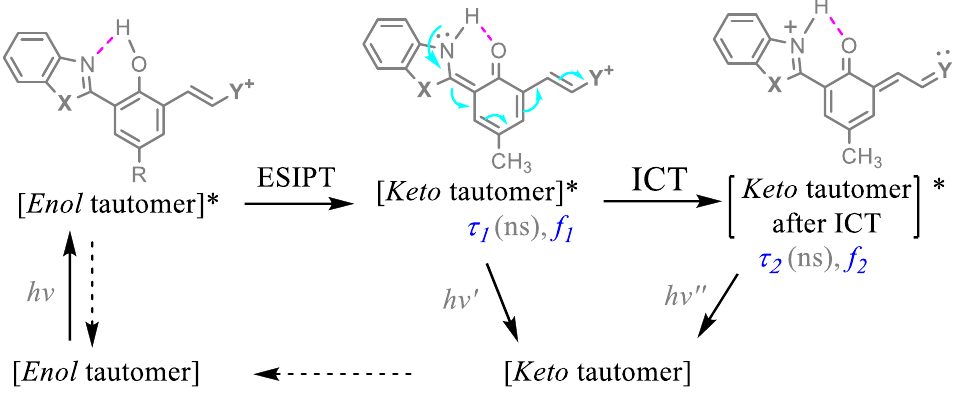
Scheme 4. Schematic illustration of the connection between fluorescence lifetimes and